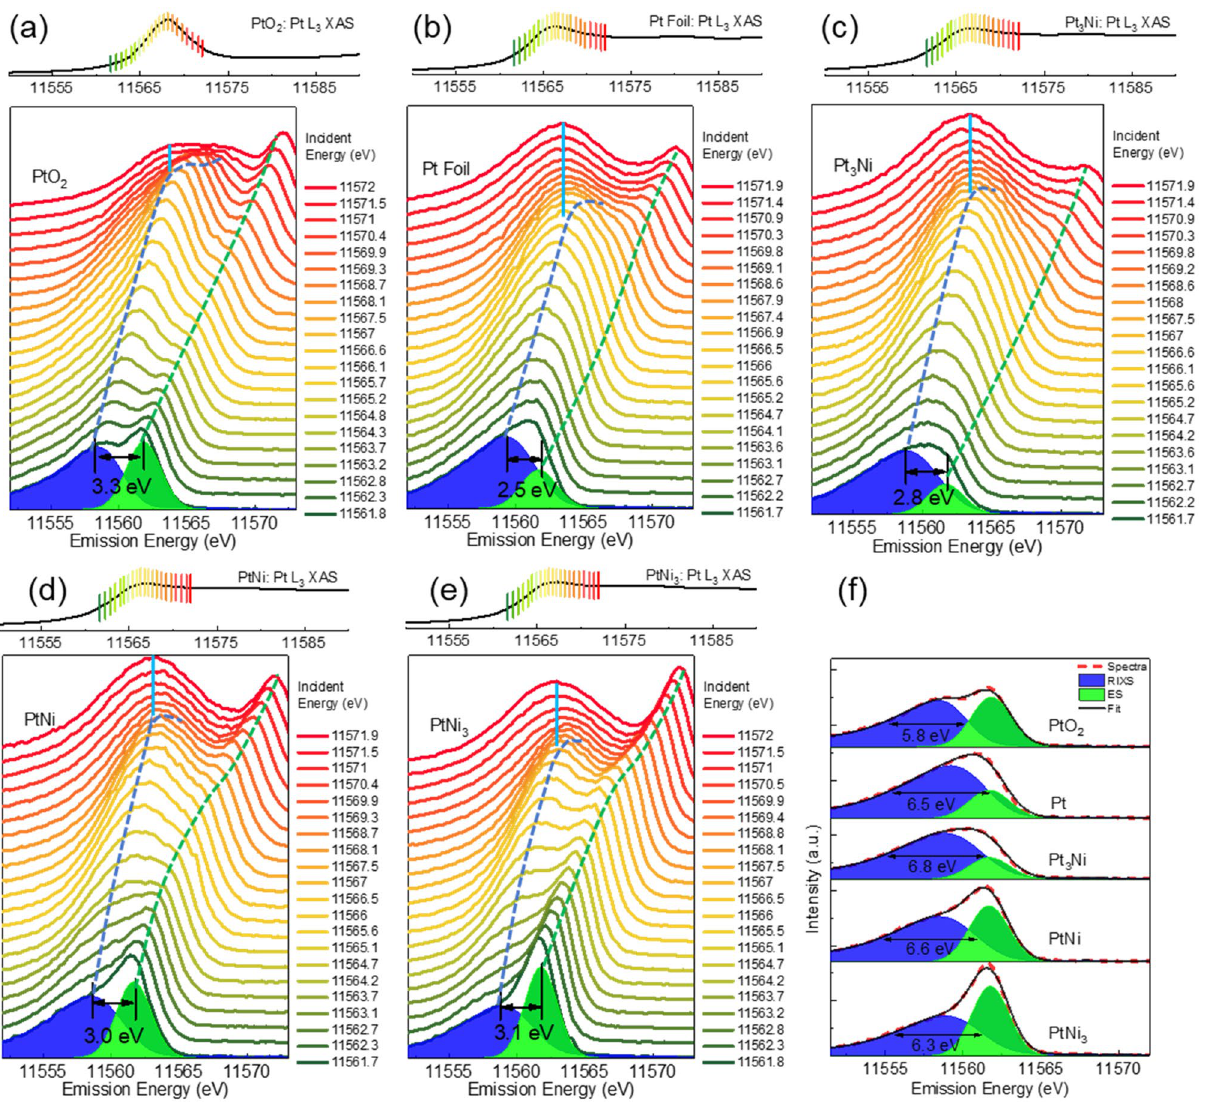
Figure 3. X-ray emission spectra from ( a ) PtO 2 , ( b ) Pt foil, and ( c – e ) Pt-Ni alloys collected across the Pt L 3 - edge with the corresponding XAS collected in normal FY mode. The energy difference (ΔE 2 ) between the RIXS peak (blue dash line) and ES peak (green dash line) below WL is labeled for each sample, with the FWHM of the inelastic peaks summarized in ( f ). ΔE 2 and FWHM are averaged numbers extracted from five spectra excited at 11,560.8–11,562.8 eV. The VTC X-ray emission ω NR is labeled in light blue straight line. The ES peak is fitted using a Gaussian peak with the half width obtained from the ES signal at the excitation energy of 11,555 eV. The detailed analysis is described in the